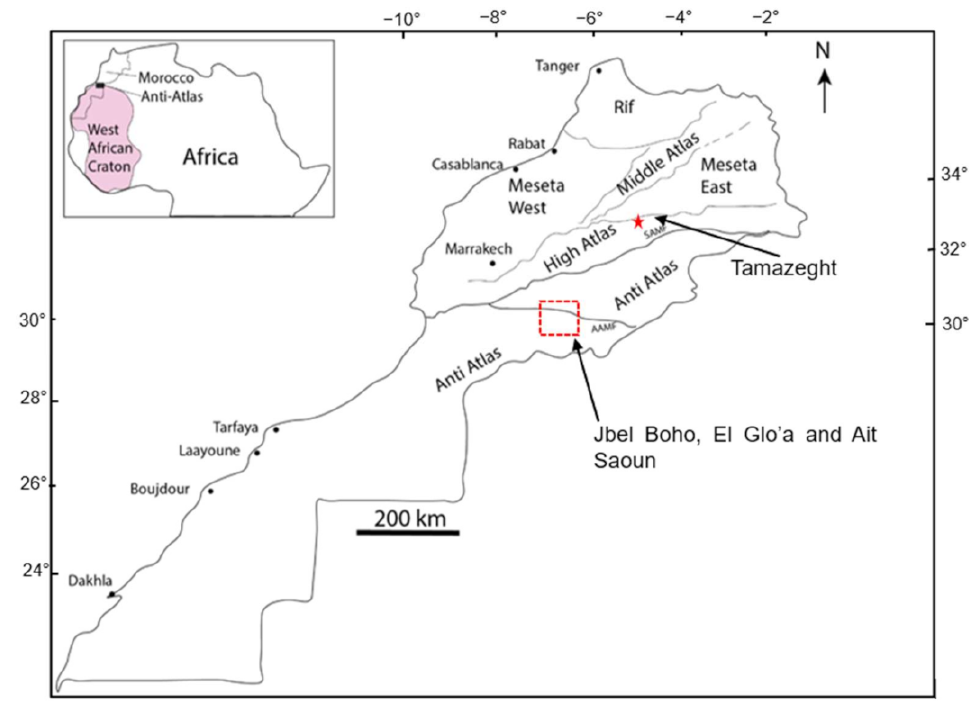
Figure 1. Map showing the location of the study areas: Tamazeght, Jbel Boho, El Glo’a, and Ait Saoun magmatic complexes. SAMF (South Atlas Major Fault) and AAMF (Ati-Atlas Major